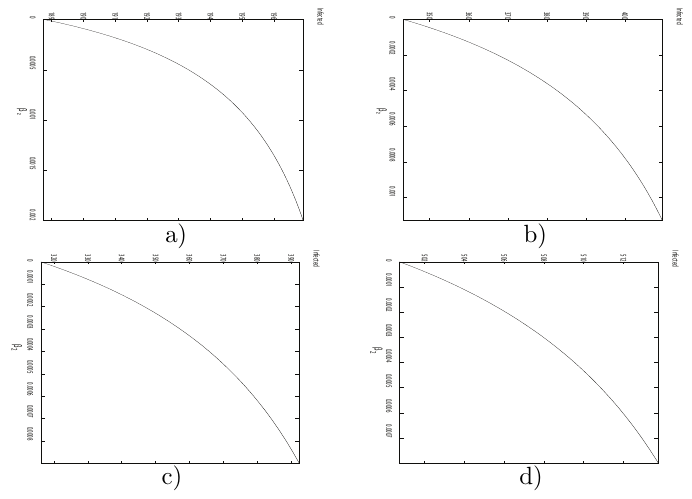
Figure 5. Plots the infected population I ( t ) against the contact rate between latent and susceptibles β 2 and corresponding to parameter values of (a) measles, (b) mumps, (c) chickenpox and (d) rubella